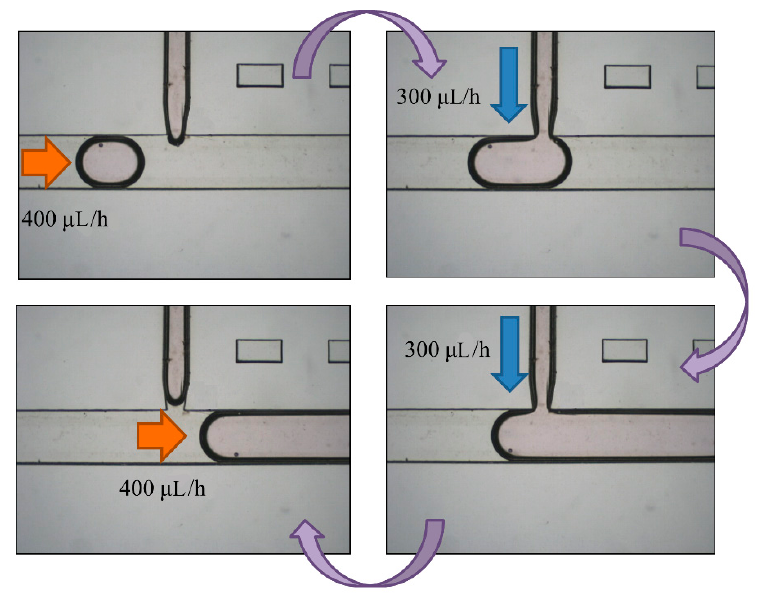
Figure 7. A selected droplet was pushed to the enlargement area with an oil inlet at flow rate of 400 μ L/h. We turned off the oil inlet and opened the enlargement area inlet to inject more medium to the droplet at 300 μ L/h. We eventually stopped the injection and opened the oil inlet to cut off the enlarged droplet.